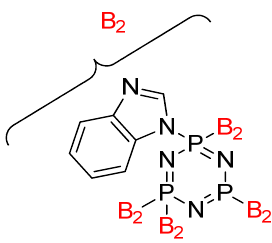
Figure 5. Benzimidazoyl substituted cyclotriphosphazene (BICP).